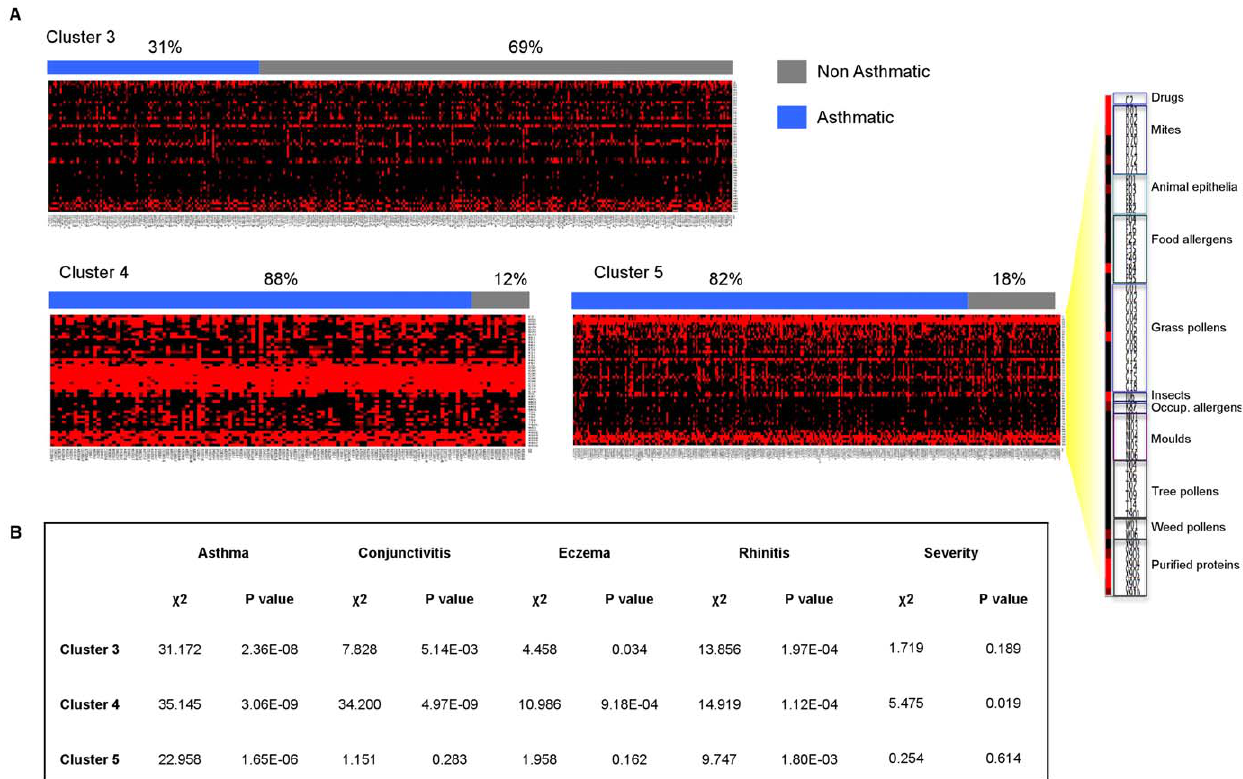
Figure 2. K-means clustering of serum reactivity profiles of 827 sera (columns) against the subset of asthma relevant allergens (rows). (A) The serum reactivity profile generated for each cluster (3–5) at k =3 are visualized. Each column represents an individual serum grouped as asthmatic (blue) and non-asthmatic (gray). Reactivity values to individual allergens are classified as either positive (scale of red - class score 1–5) and negative (black - class score 0). (B) The distribution of atopic conditions in each cluster was assessed using the Pearson’s X 2